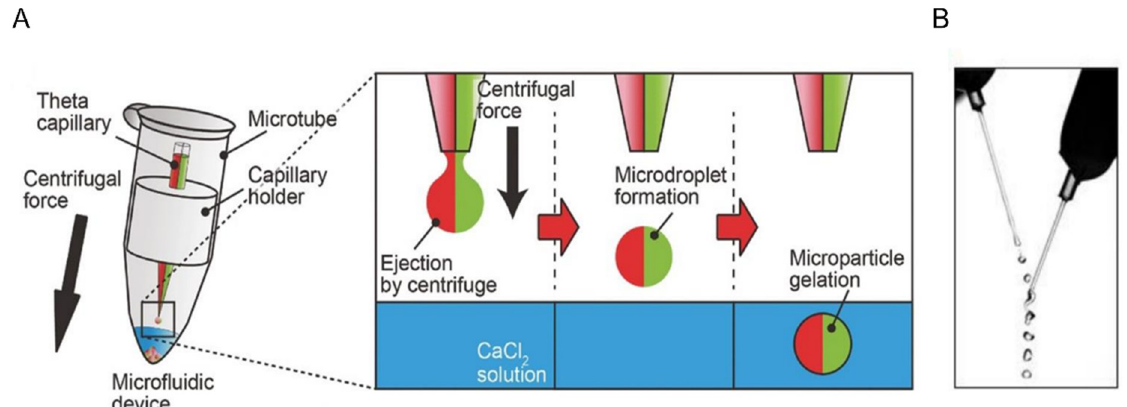
Figure 2. ( A ) The centrifugal microfluidic device consisting of a microtube, a Theta capillary holding the alginate solution, a capillary holder and calcium chloride solution. When centrifugal force is applied, droplets of the alginate solution fall into the CaCl 2 solution, where gelation takes place. ( B ) The in-air microfluidic working principle is shown here as two jets of two reactive liquids that meet to form droplets which are then transformed to microgels. Upon the contact of the two jets, gelation begins, and the droplet transforms into a microgel particle. Panel ( A ) has been reproduced with a permission from Wiley [59] and Science Advances for Panel ( B ) [58].